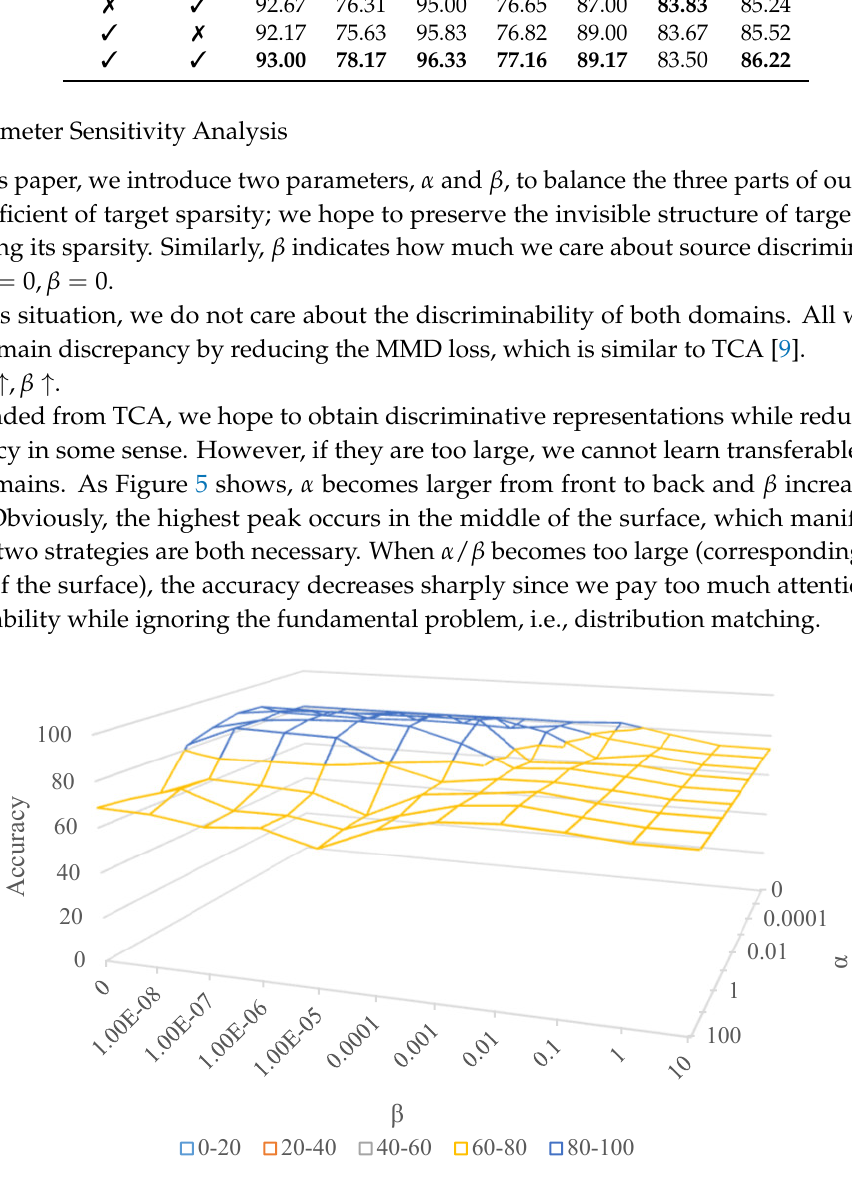
Figure 5. Accuracy (%) with different α and β on